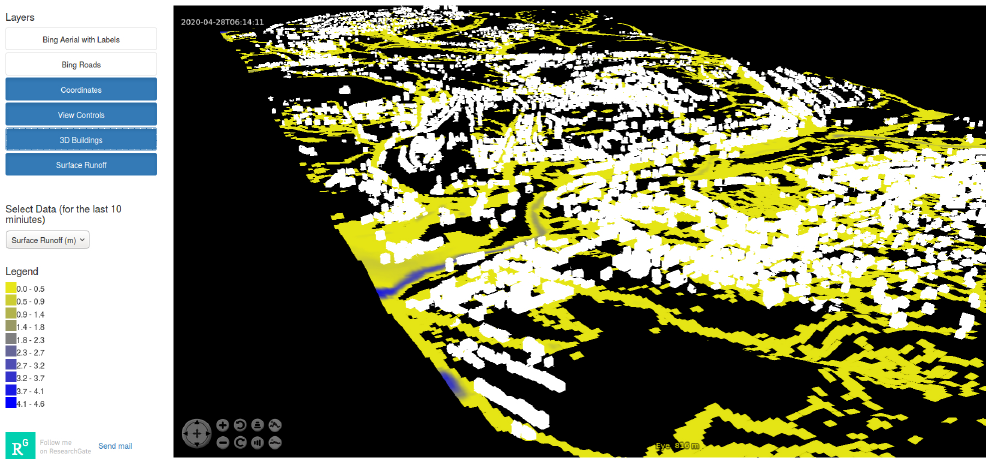
Figure 5. The 3D web-interface WupperWWEM for the visualization of “live” flood warning in an urban area of Wuppertal